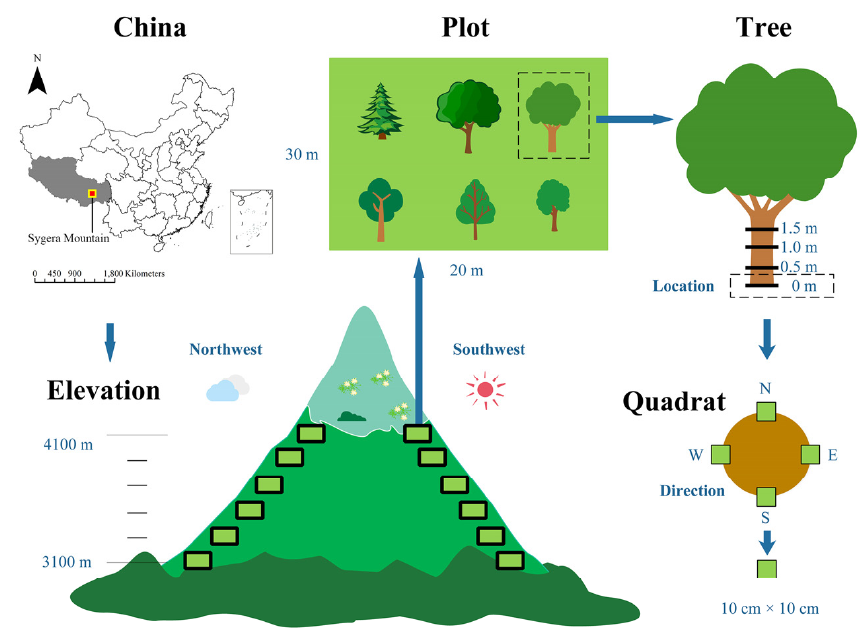
Figure 1. Bryophytes design in Sygera Mountains. A hierarchical nesting design to sample bryophytes: elevation zone, plot, tree, quadrat.